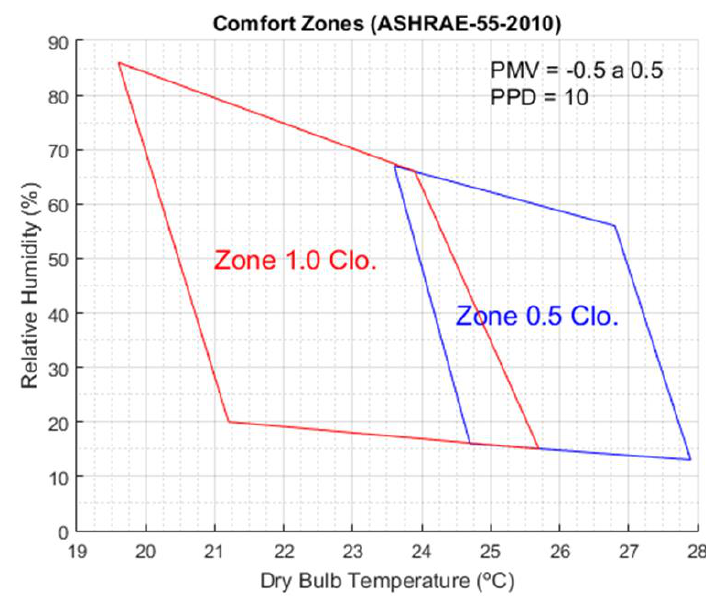
Figure 6. Comfort zones recommended by ASHRAE [26].